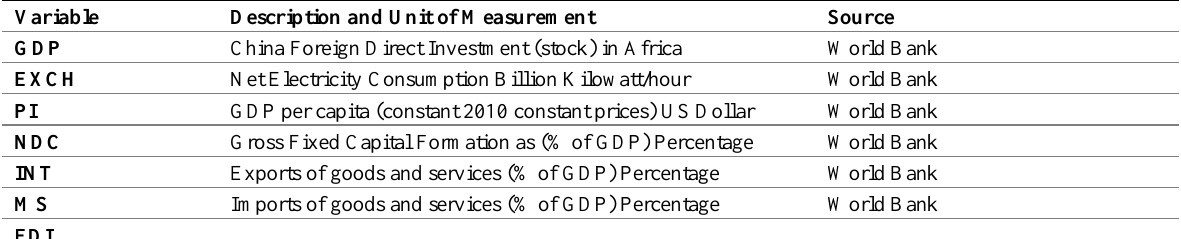
Table 1: Summary of Variable